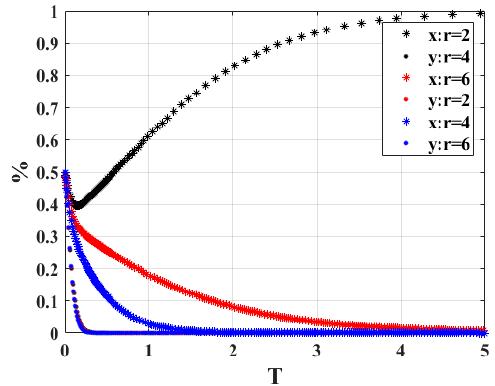
Figure 6. Sensitivity analysis of “ r ”.